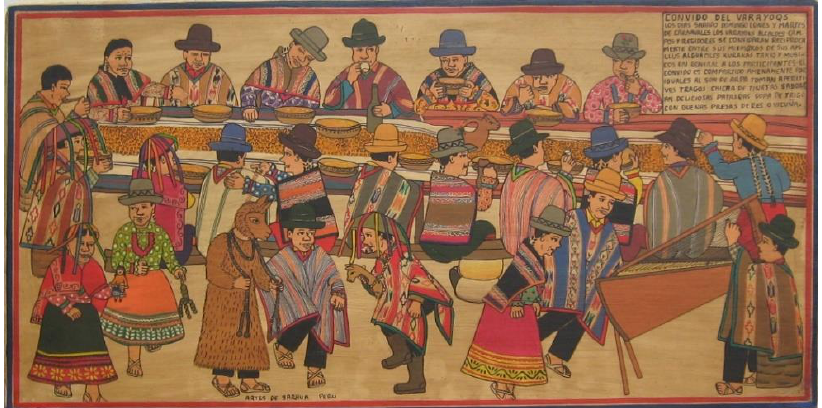
Figure 1. Primitivo Evanán and ADAPS, Convido del Vayayoqs , the 1990s, synthetic paints on board, 40 cm × 60 cm. Collection ADAPS. Photo credit: Gabriela Germana.